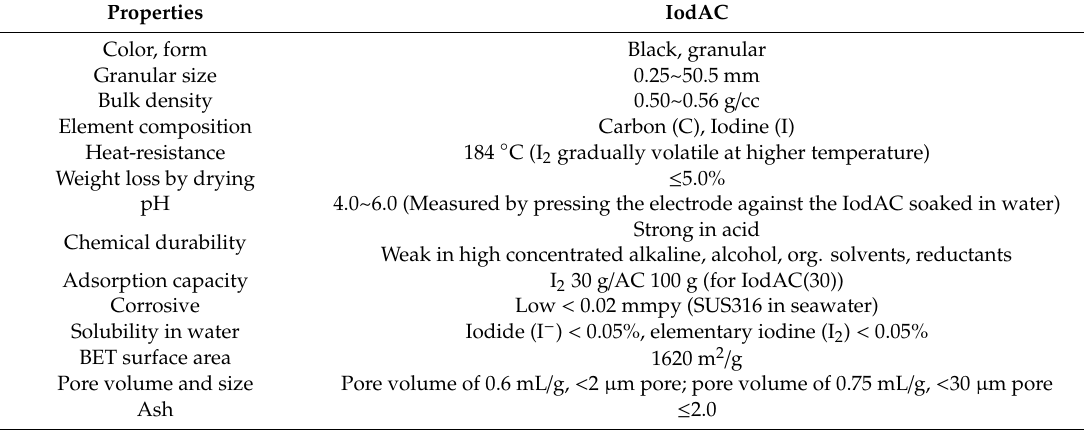
Table 1. Main characteristics of